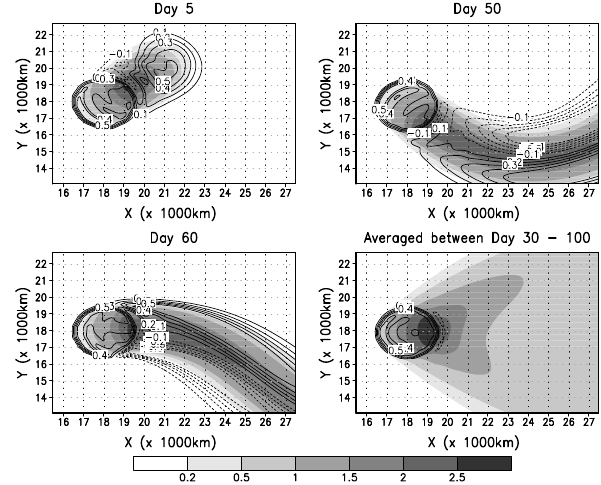
Fig. 16. DTE computation for a fire injecting emissions inside a circle of diameter L = 3000 km in the presence of constant advection over the domain at a given time. At time t , the wind in the x and y direction is respectively U = U 0 (1 . + cos(2 πt/τ ) 2 ) / (2) and V = U 0 sin(2 πt/τ ) / (2) with U 0 = 10 m/s. τ = 1 . 25 πδt is chosen so that the oscillation of wind is not in phase with the diurnalcycle. On each panel, the concentration is shown (shaded) together with the associated DTE contours (-0.5, -0.4, -0.3, -0.2, -0.1, 0.1, 0.2, 0.3, 0.4, 0.5).